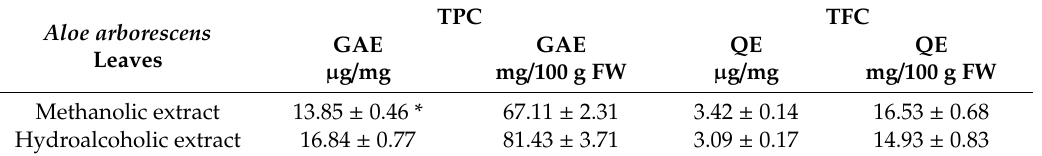
Table 2. Total phenolic and flavonoid contents of Aloe arborescens leaf